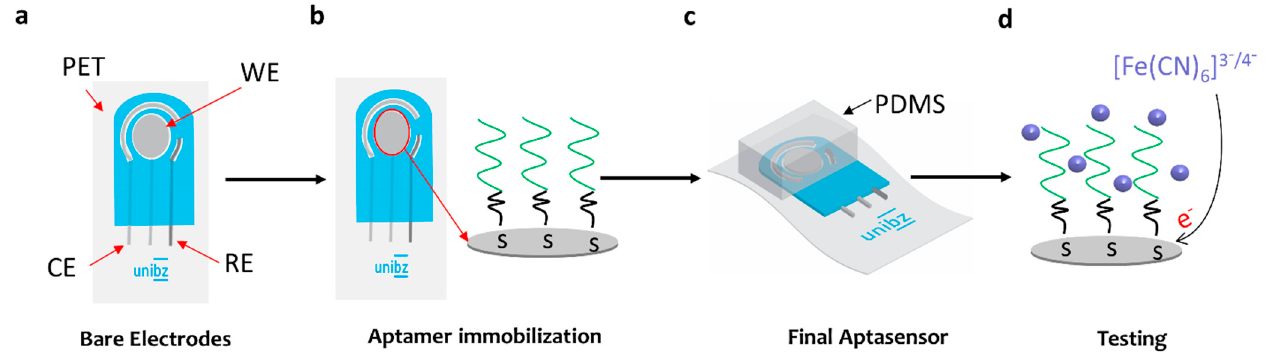
Figure 3. Fabrication flow of aptasensor. ( a ) Screen printing of electrodes, ( b ) immobilization of the aptamers using a self-assembled-monolayer, ( c ) final aptasensor cover by a PDMS chamber, and ( d ) testing of the performance of the aptasensor by using [Fe (CN)6] 3 − /4 − as an electrolyte.